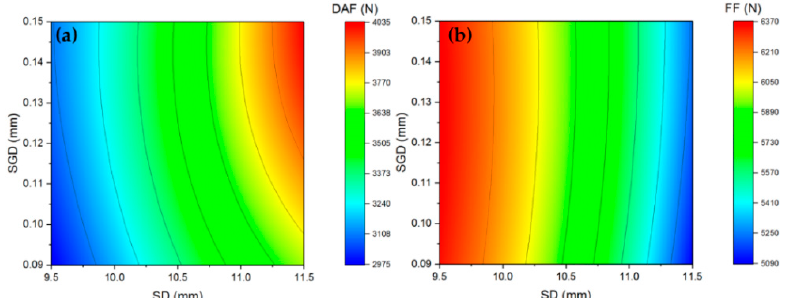
Figure 7. Contour plots of: ( a ) The downward axial force during the RAFSW process, and ( b ) failure force at tensile shear test versus shoulder diameter ( SD ), and shoulder groove depth ( SGD ), while other geometry and process parameters are the same as parameters of sample No. 21. The contour plots were extracted from developed ANN models in this paper.